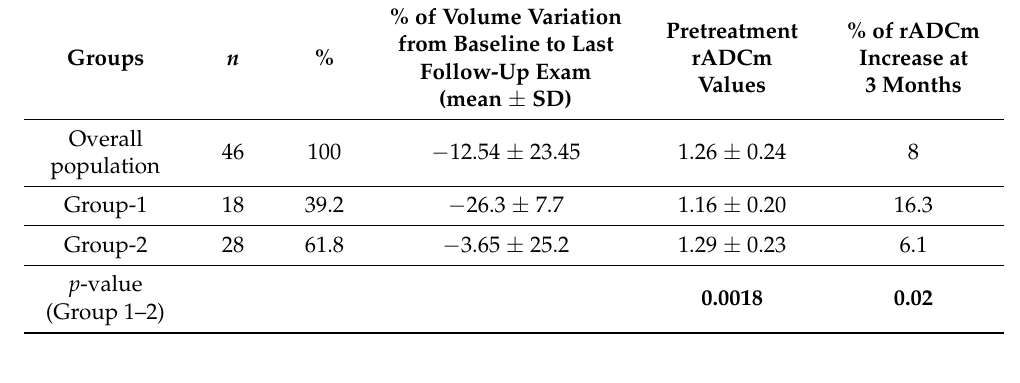
Table 3. Patients grouped by volume variation percentage (VV, threshold − 20%). A significant difference in the baseline rADCm values was found between groups ( p = 0.0018) with lower pre- treatment values detected in patients with higher VR (Group-1).